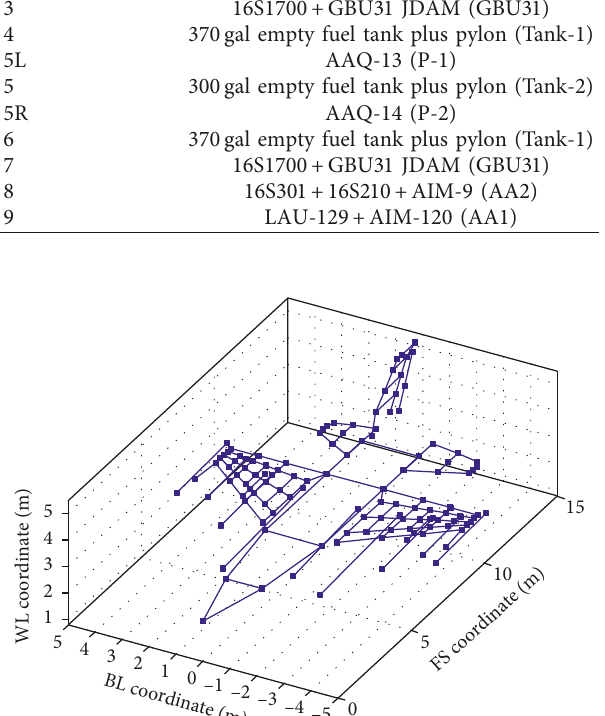
Figure 5: F-16 measurement points for FE model updating